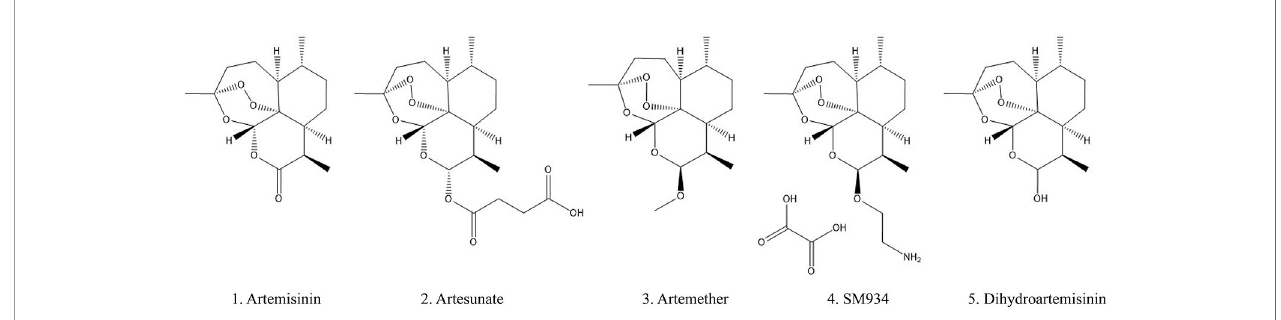
FIGURE 1 | Chemical structures of artemisinin and